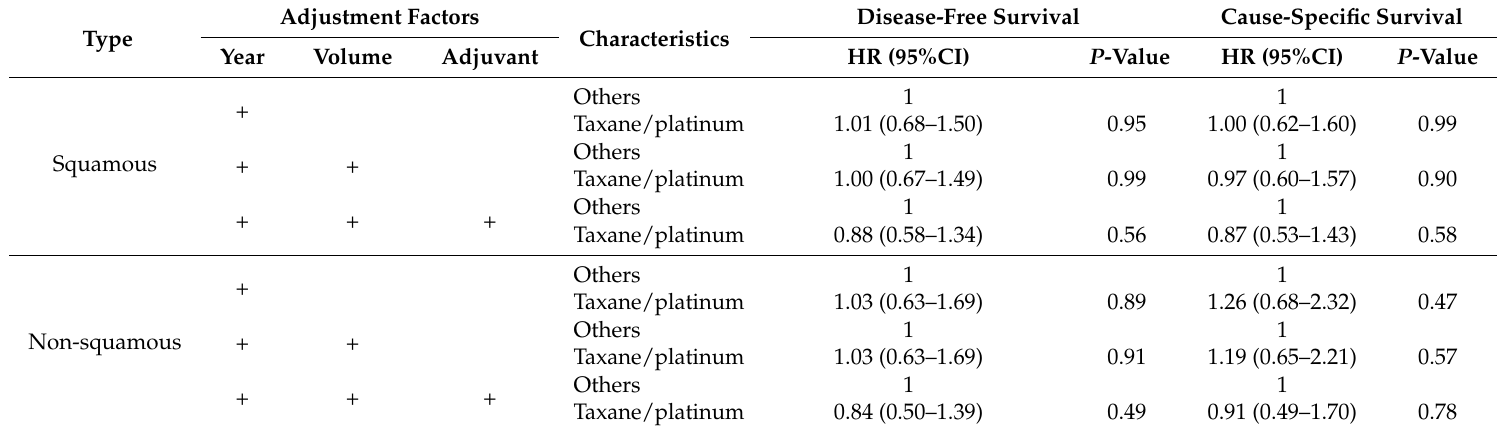
Table 4. Adjustment models for neoadjuvant chemotherapy type and survival outcome.